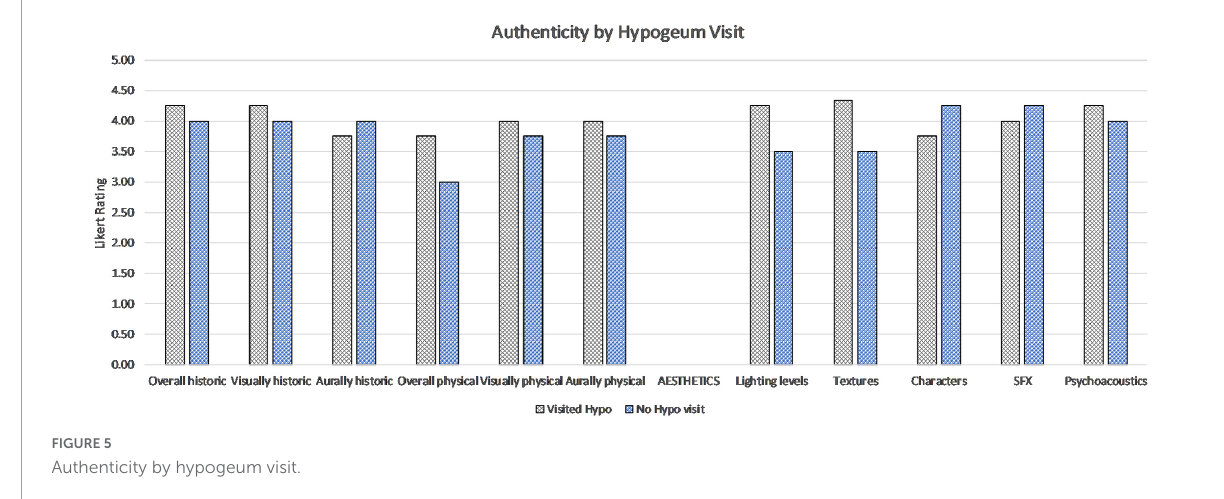
FIGURE5 Authenticity by hypogeum visit.